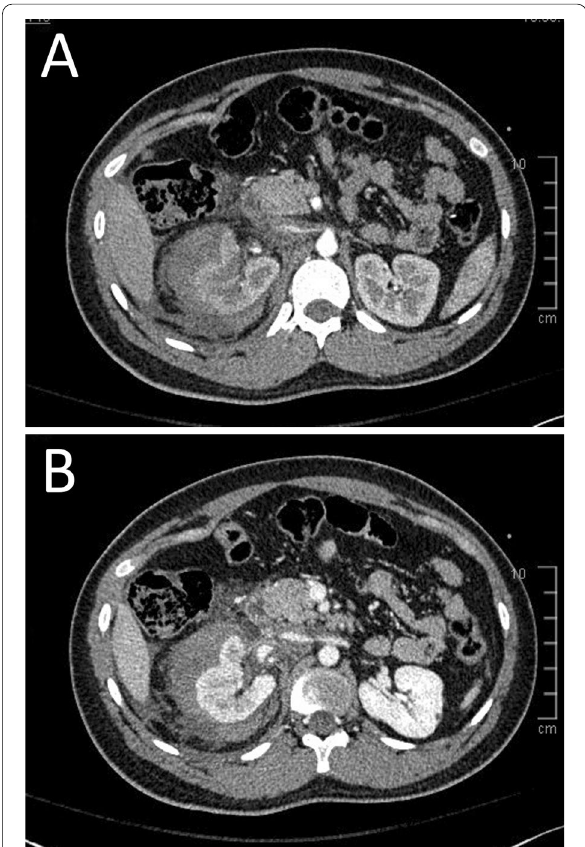
Fig. 1 A An axial cut of contrast-enhanced CT of the kidney at (B) cortical-medullary phase: a right-sided upper pole renal tumour and at B nephrographic phase: an enhancing right-sided upper pole renal tumour